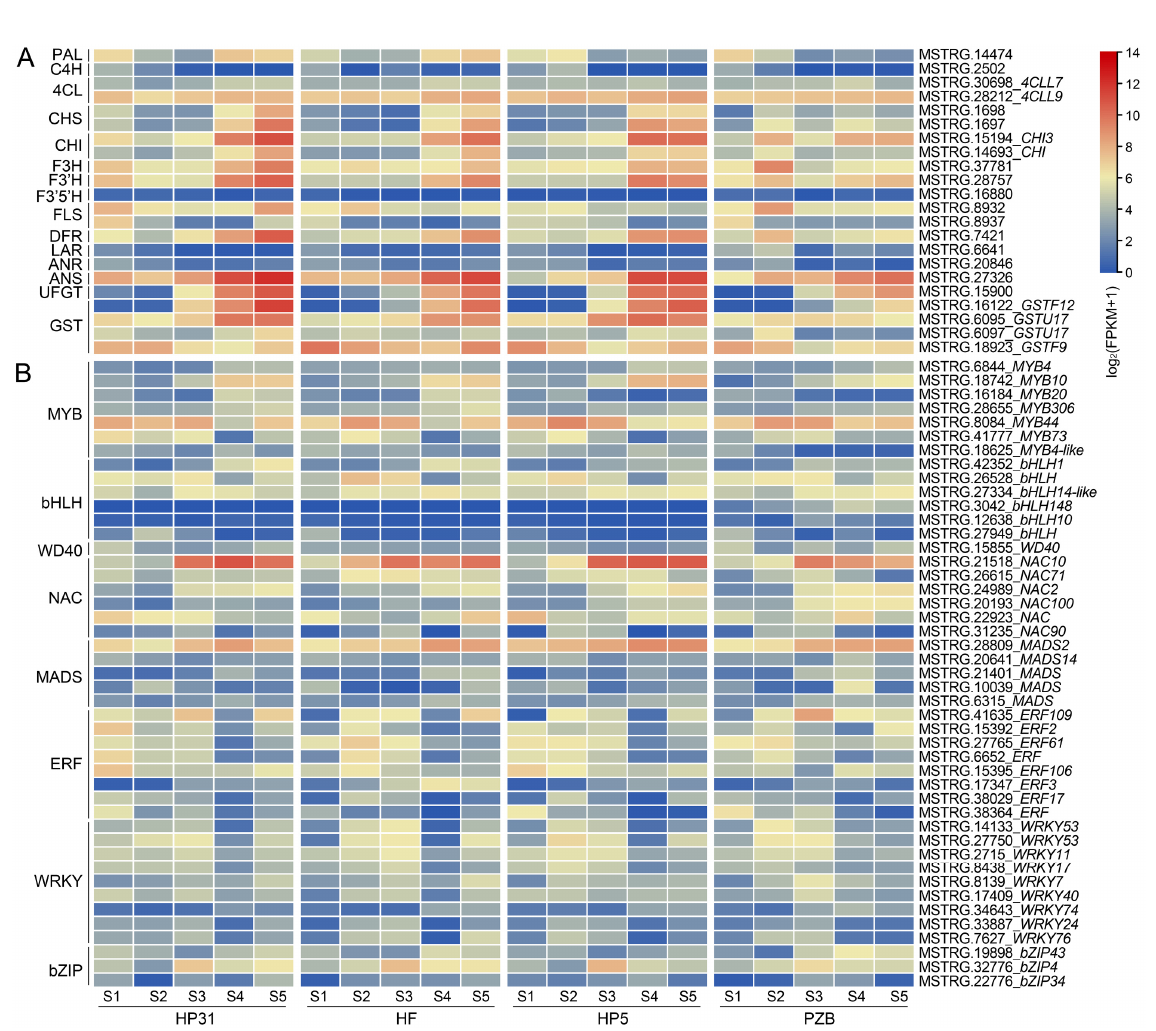
Figure 3. Expression heatmap of structural genes ( A ) and transcription factors ( B ) associated with anthocyanin biosynthesis. The heatmap represents the expression of corresponding genes in Chinese cherry fruits, and from blue to red in the heatmap indicates the expression levels of genes ranging from low to high. The color scale of the heatmap represents expression levels as log 2 (FPKM + 1).